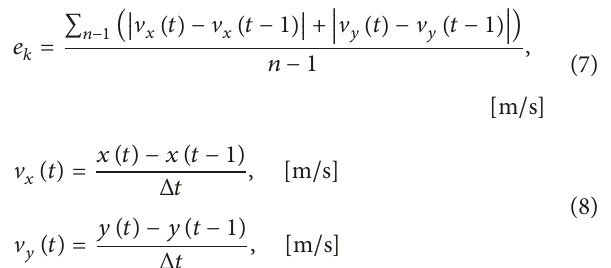
measurement area and for every cell the percentage of the time it is occupied is determined by